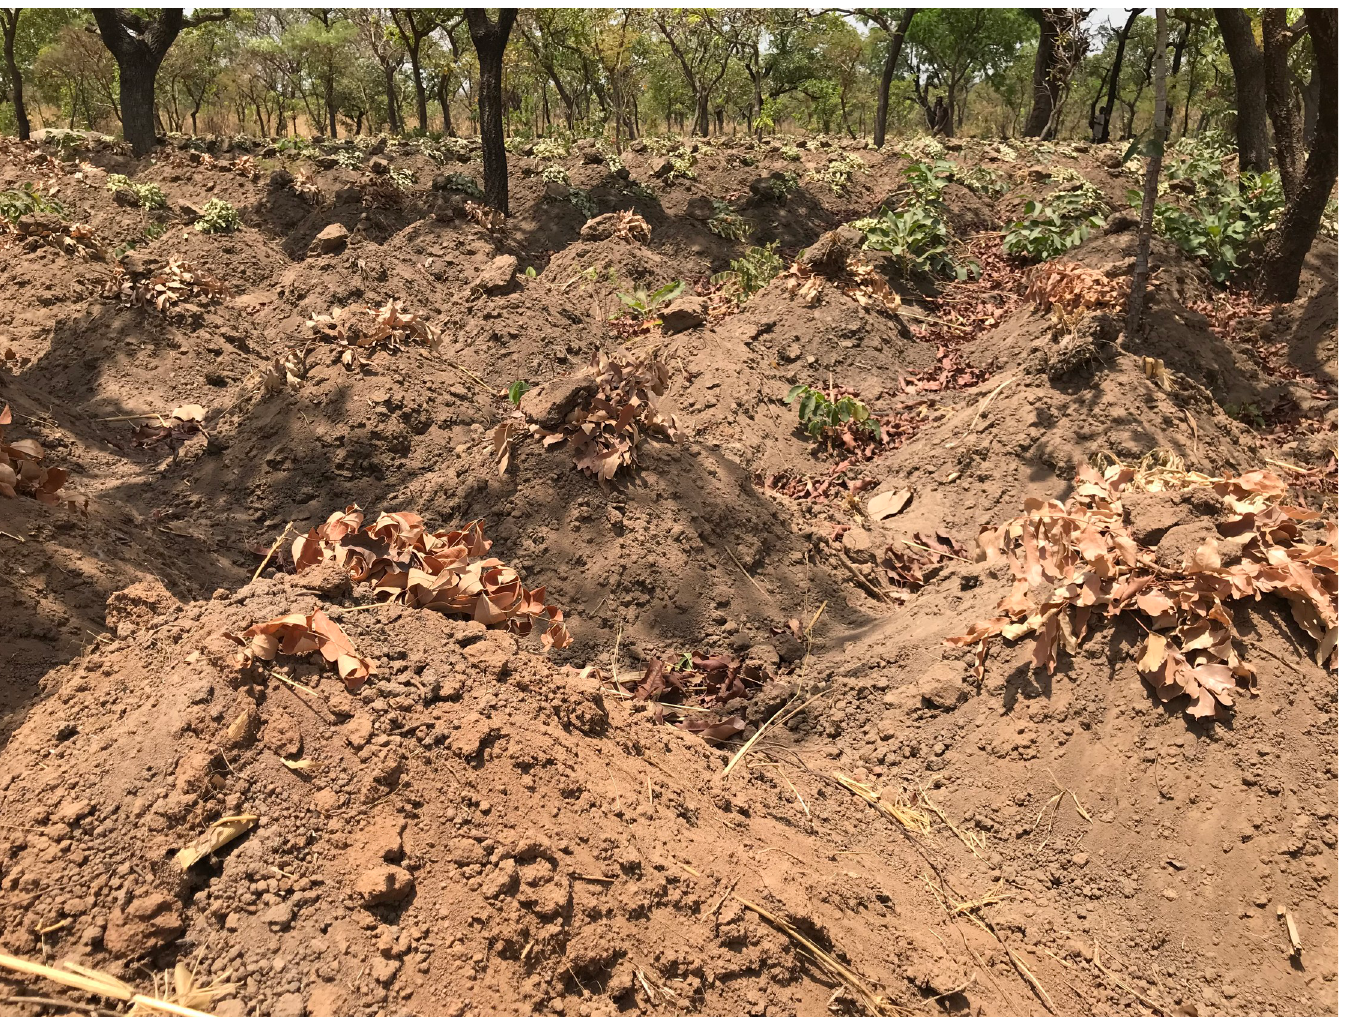
Fig 2. Yam mounds topped-off with leaves and branches to prevent desiccation of seedlings- a frequently reported hiding place of venomous snakes.